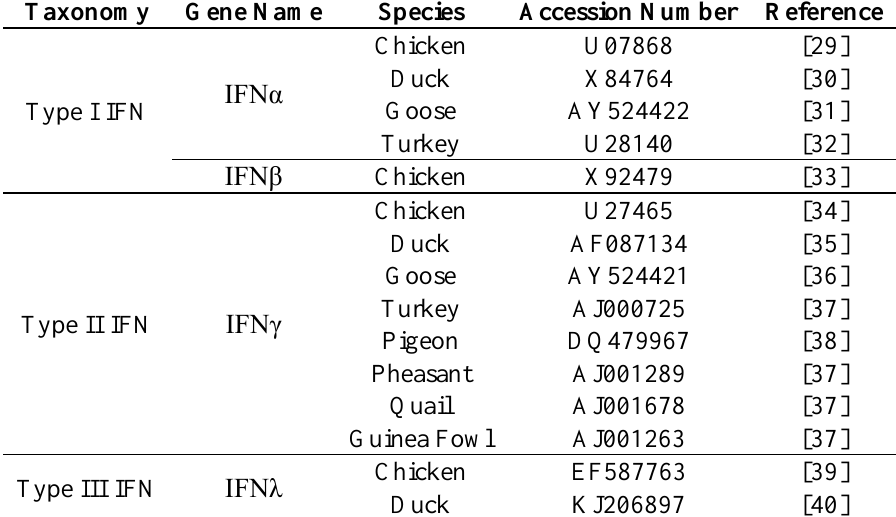
Table 3. List of the interferons identified in